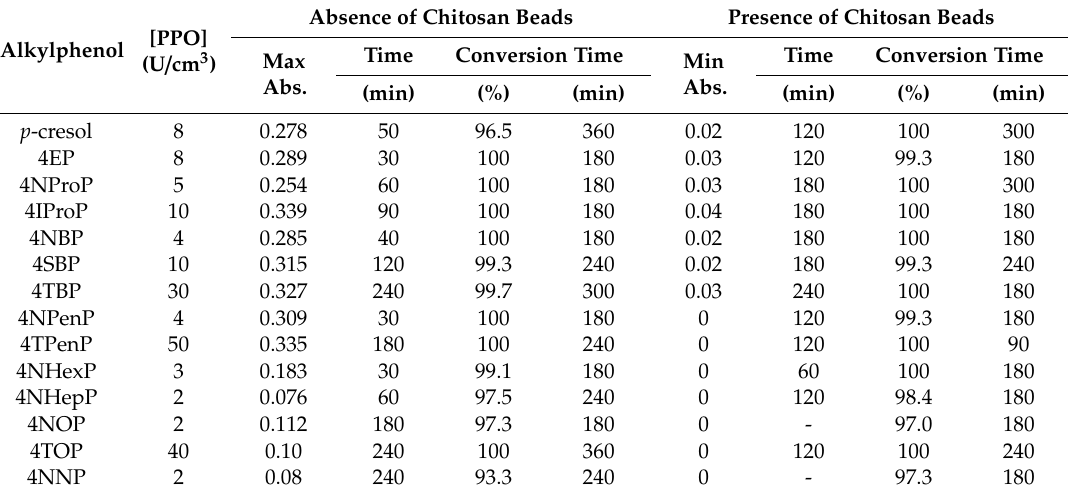
Table 2. Removal of linear and branched alkylphenols through the PPO-catalyzed quinone oxidation and subsequent quinone adsorption on chitosan beads (0.10 cm 3 / cm 3 ) at pH 7.0 and 40 ◦